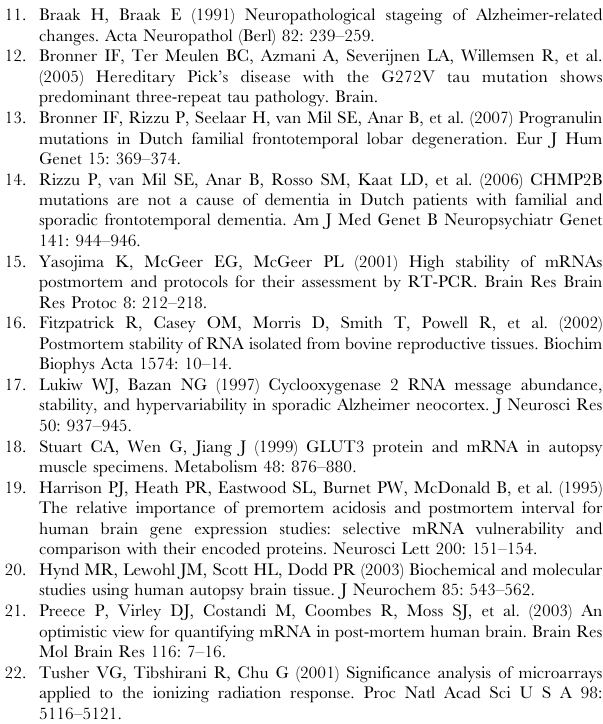
Table S1 Overview of genes detected to be significantly different from background levels determined using non-demented controls. Amounts of significant different probes are given per pathology- defined group. Alzheimer’s disease: AD, Pick’s disease: PiD, Frontotemporal dementia: FTD and progressive supranuclear palsy: PSP. When possible probes are named using official gene